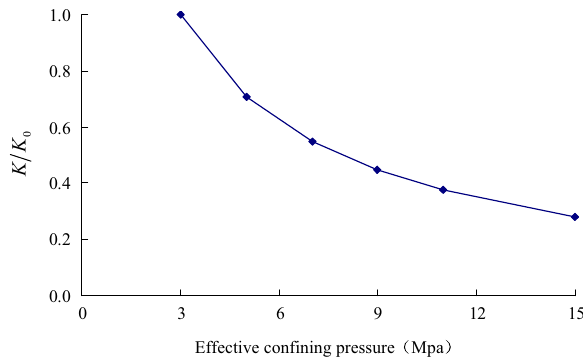
Fig. 7 Change laws of the permeability with effective confining pressure (the 1st